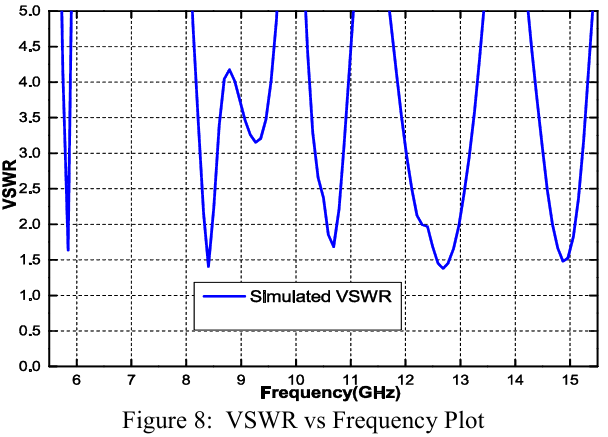
Figure 7: Gain and Directivity vs Frequency plot